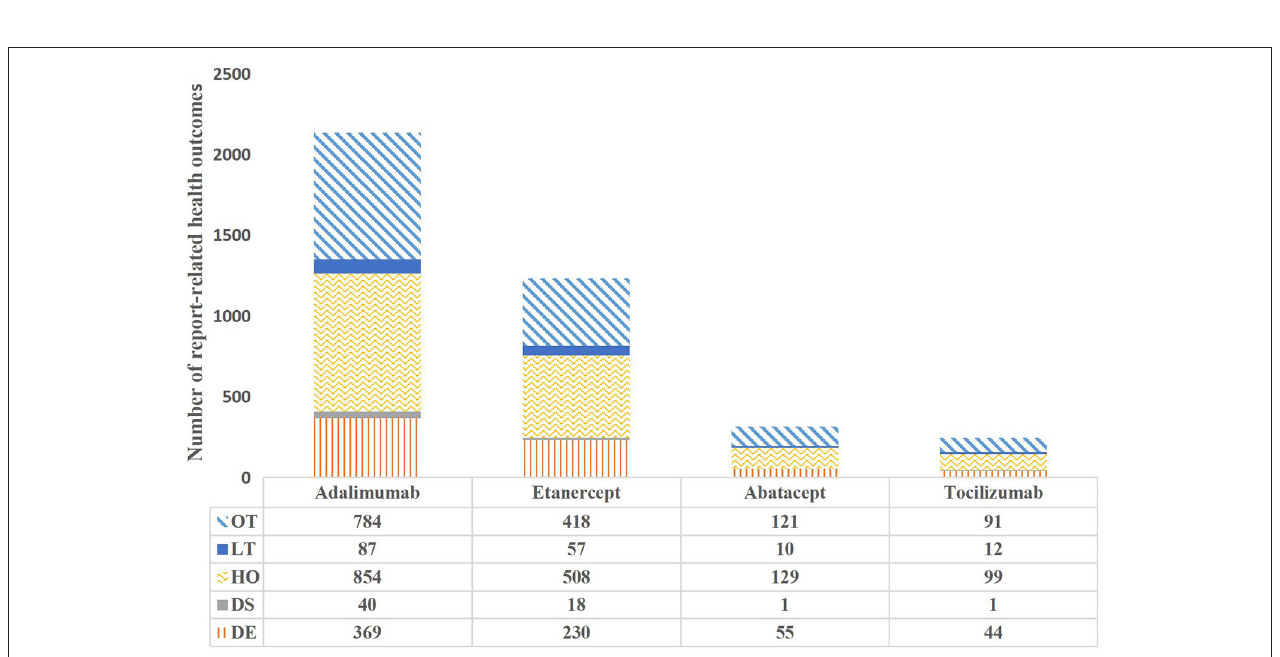
Frontiers in Pediatrics |